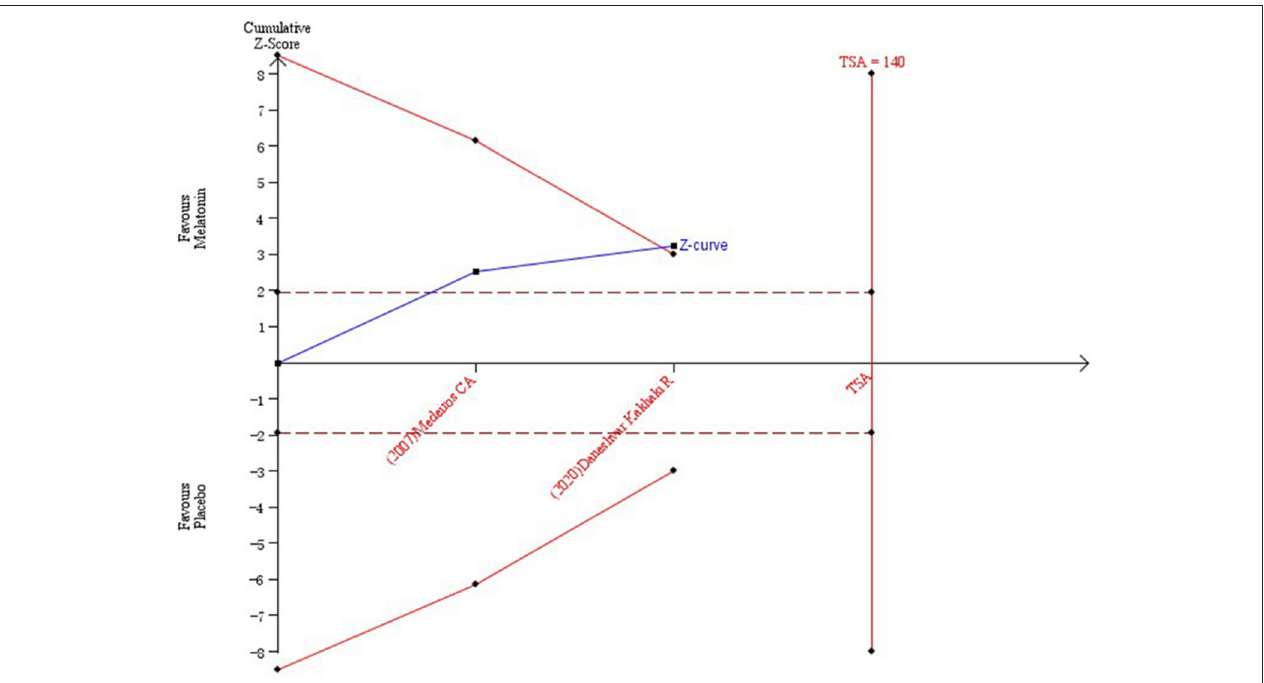
FIGURE 4 | Trial sequential analysis of the cumulative meta-analysis of the efficacy of melatonin vs. placebo on subjective sleep quality in patients with PD.